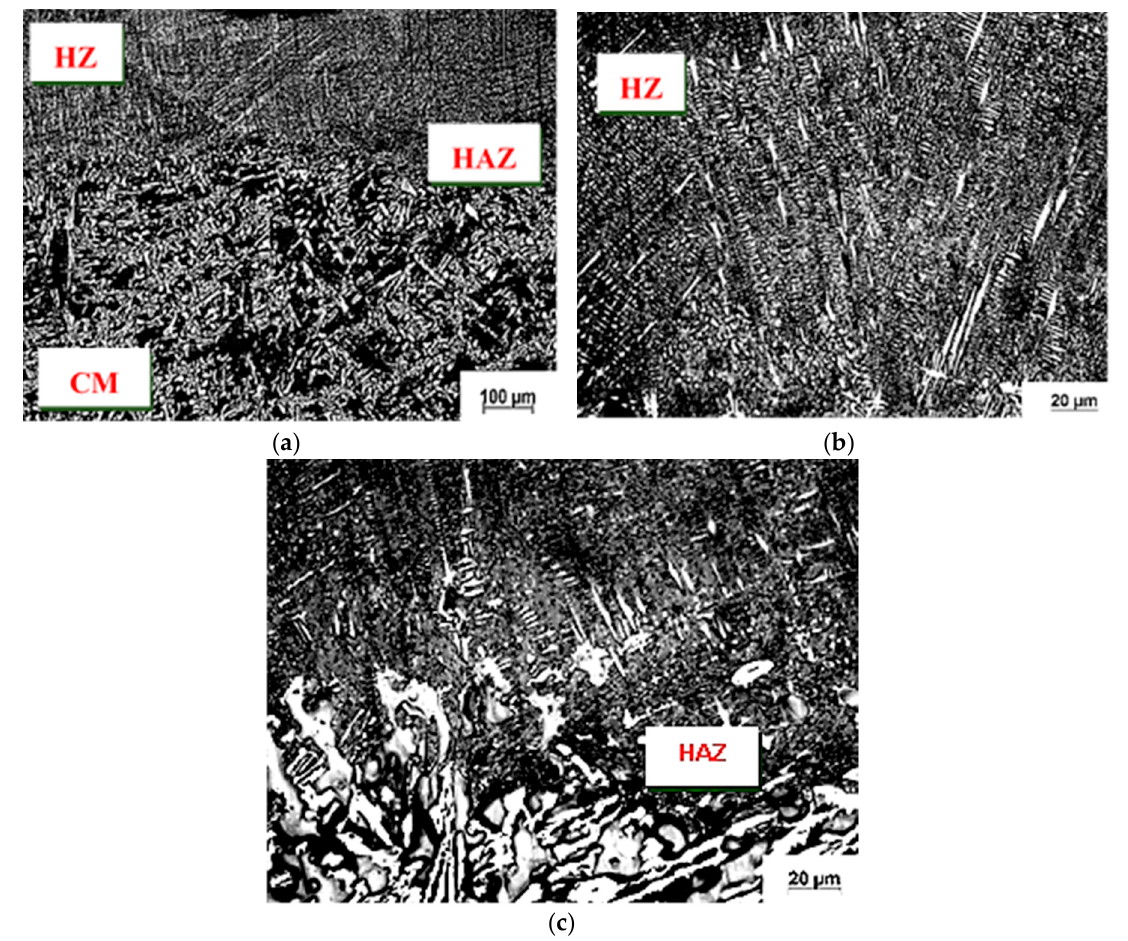
Figure 8. Typical microstructure features of laser heat-treated (LHT) S2 (Ni–hard 4) samples at a constant power of 1000 W and laser scanning speed of 5 m·min − 1 : ( a ) the entire microstructure, ( b ) the hardened layer and ( c ) the heat affected zone at higher magnifications.